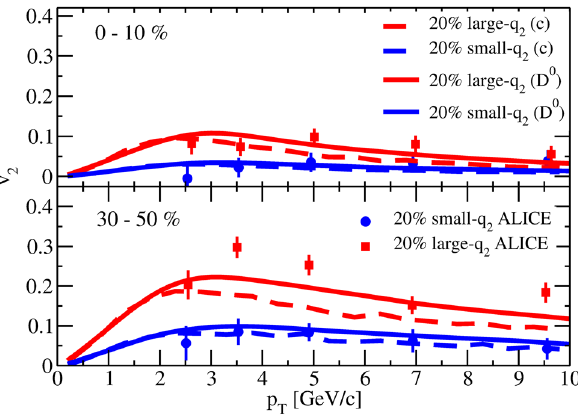
Fig. 7 Ellipticflow v 2 atmid-rapidityfor D mesonsasafunctionof p T in the 20% large- q 2 and 20% small- q 2 events for the centrality classes 0–10% (upper panel) and 30–50% (lower panel) for PbPb collisions at 5 . 02 TeV. Dashed lines refer to charm quarks v 2 while solid lines refer to D mesons v 2 . The experimental data are taken from ALICE measurements [56]